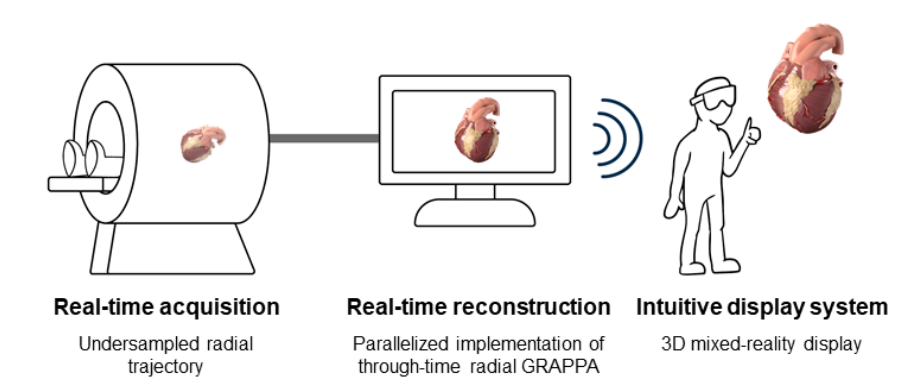
Figure 1. Concept illustration of the real-time, online mixed-reality visualization system. MR data are collected using an undersampled, radial trajectory for rapid acquisition. Real-time image reconstruction is performed using a parallelized implementation of through-time radial GRAPPA. The final images are rendered in a mixed-reality headset for intuitive